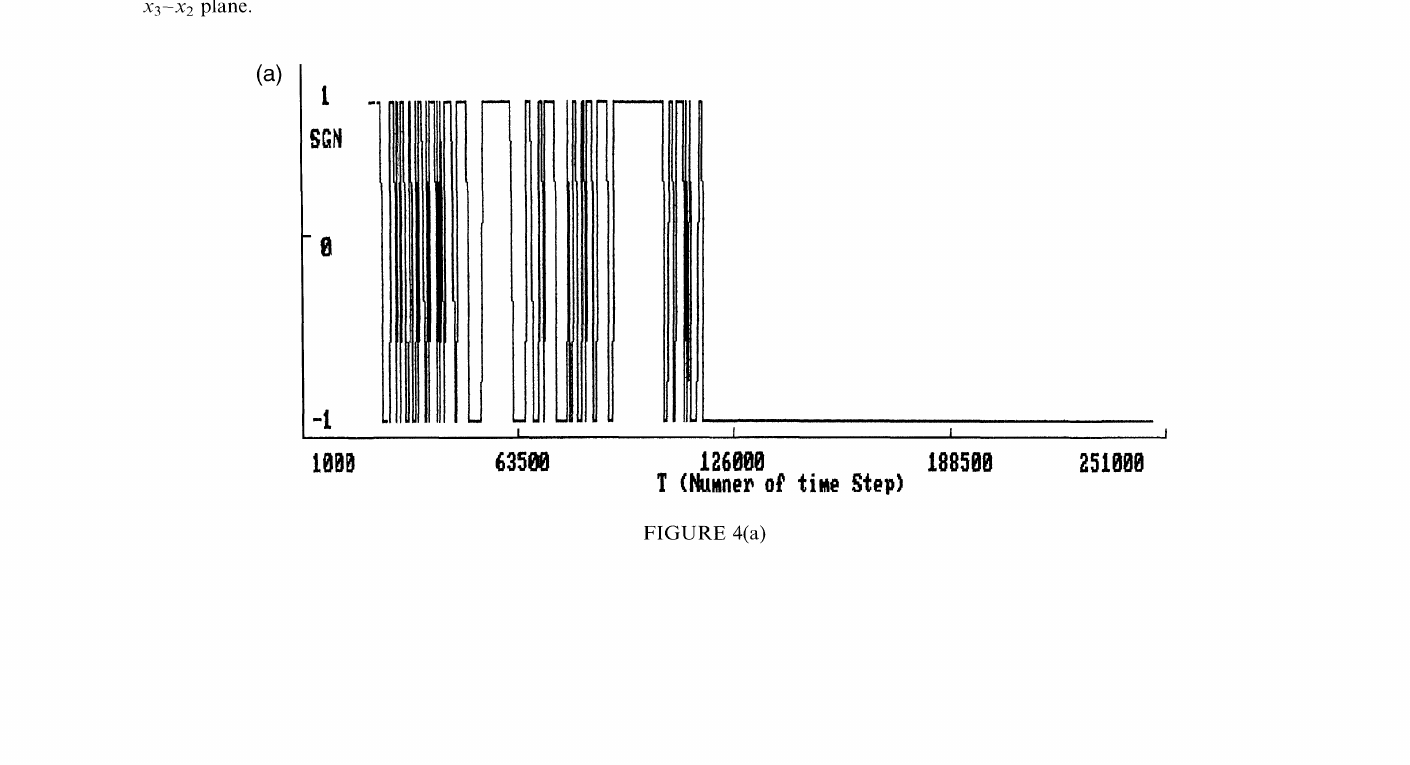
v. (a) Projection in the Xz-X plane. (b) Projection in